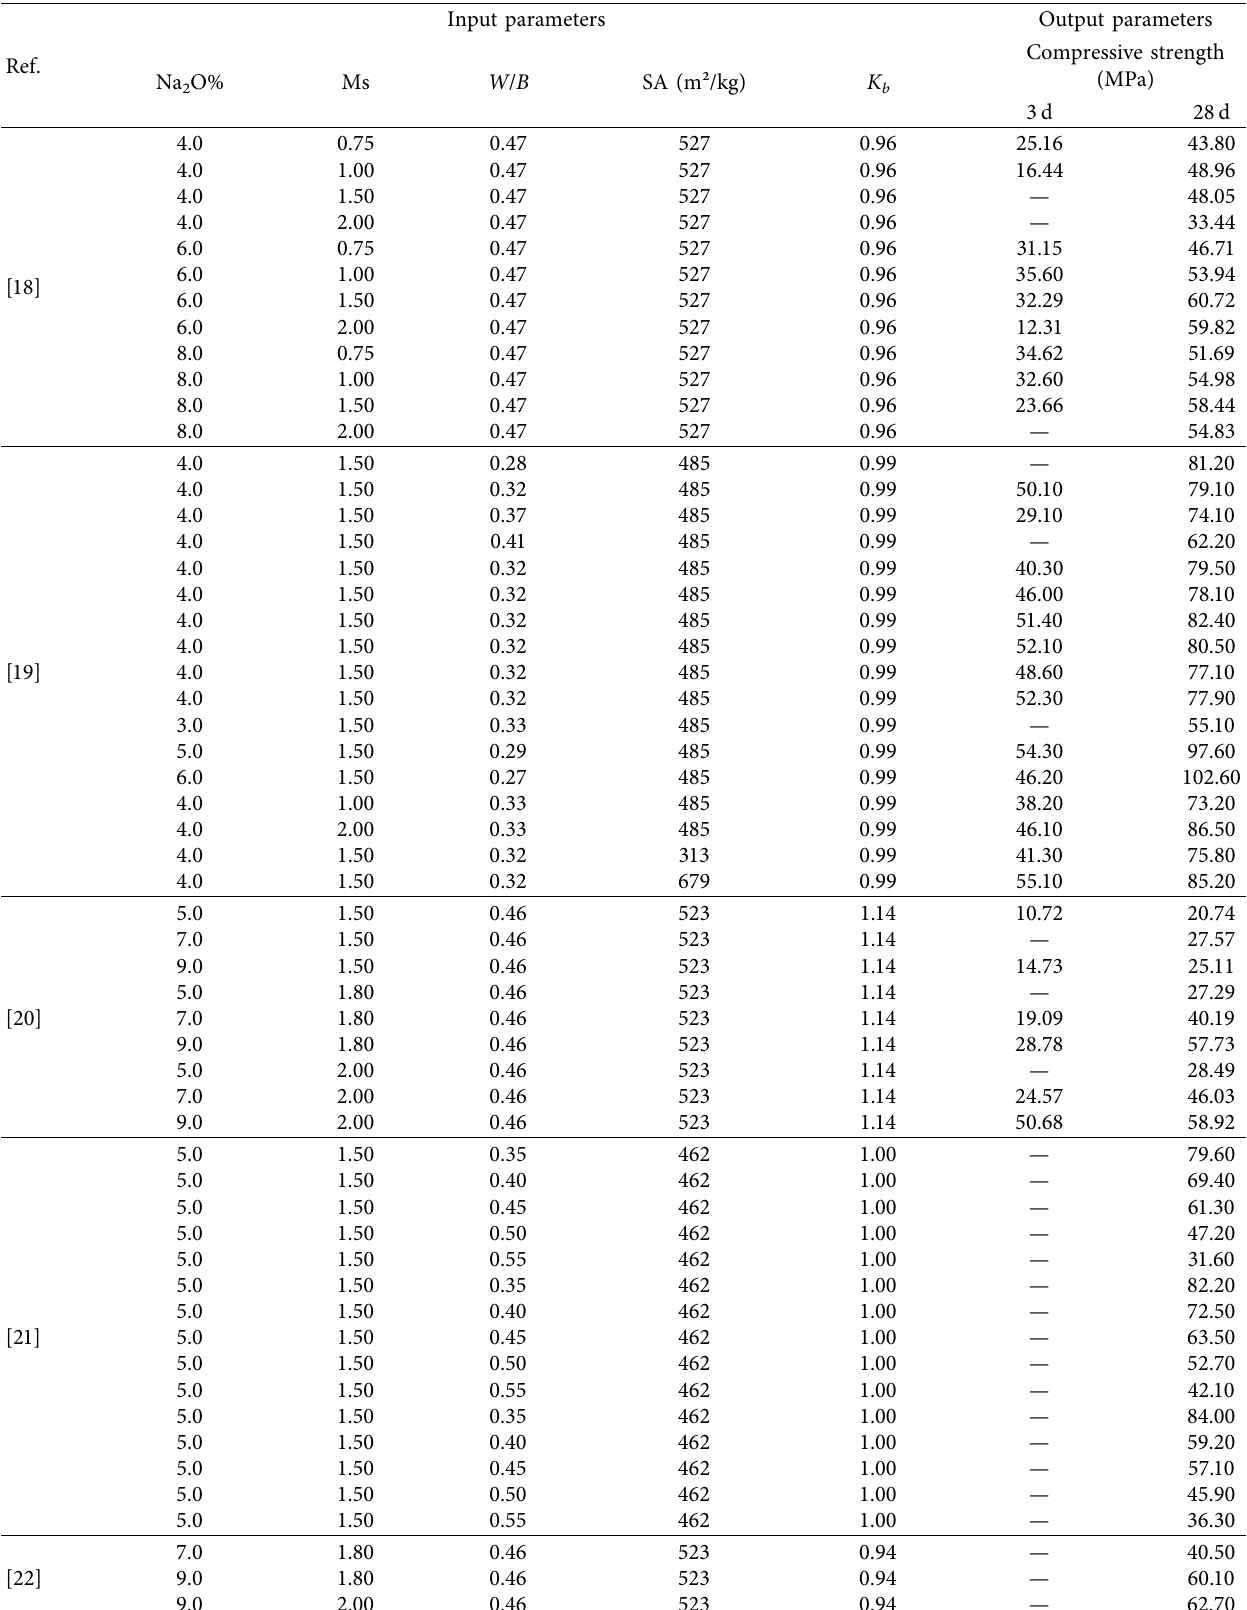
Table 1: Literatures and input/output